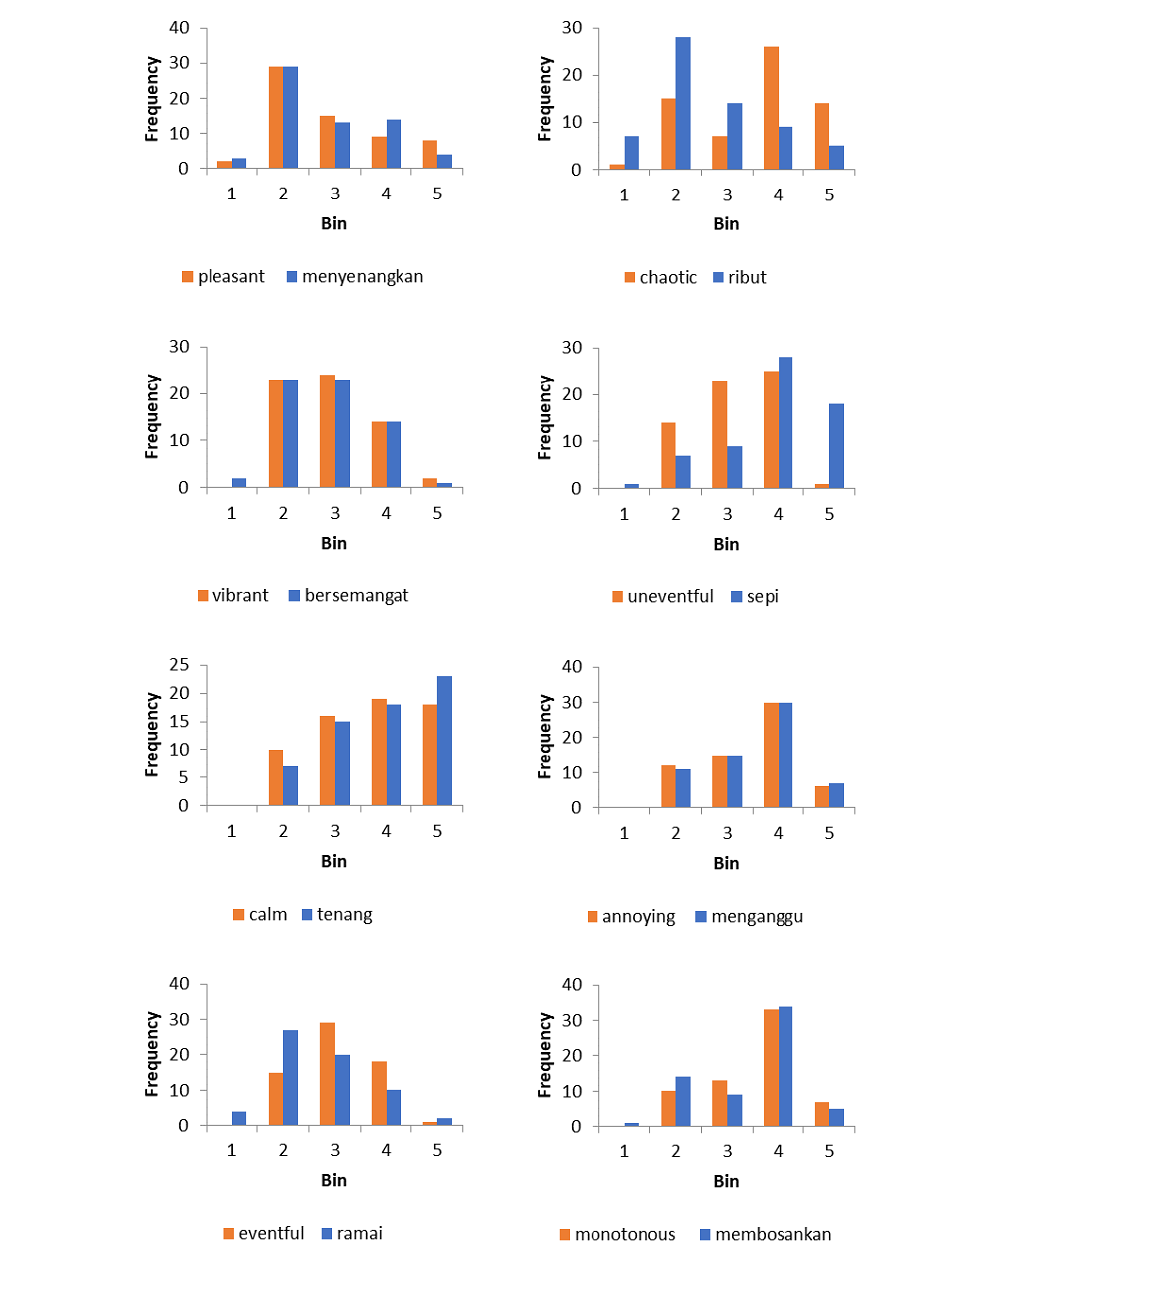
Fig. 4. Histogram of rating from in situ experiment using Indonesian and English attributes. sian attributes (M=-2.51, SD=3.29) is significantly different from the score calculated from English attributes